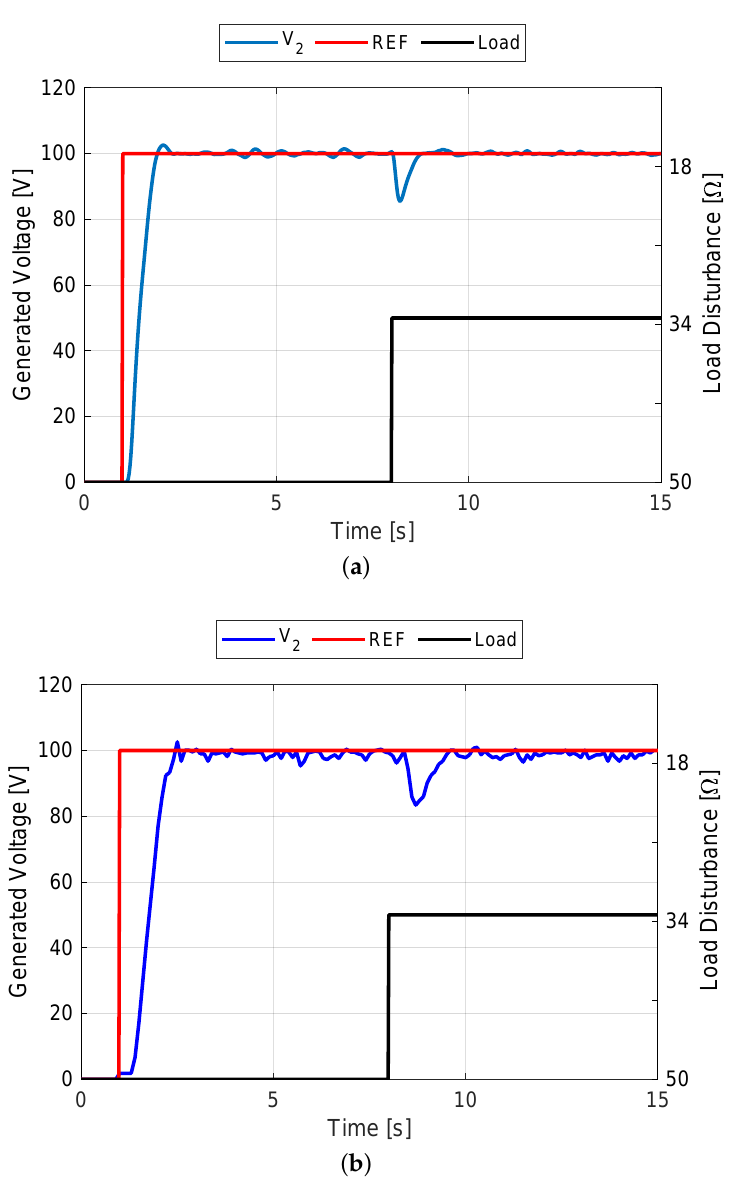
Figure 9. Voltage PID controller response using V 1 as manipulated variable (100 V reference): ( a ) Simulation result and ( b ) experimental